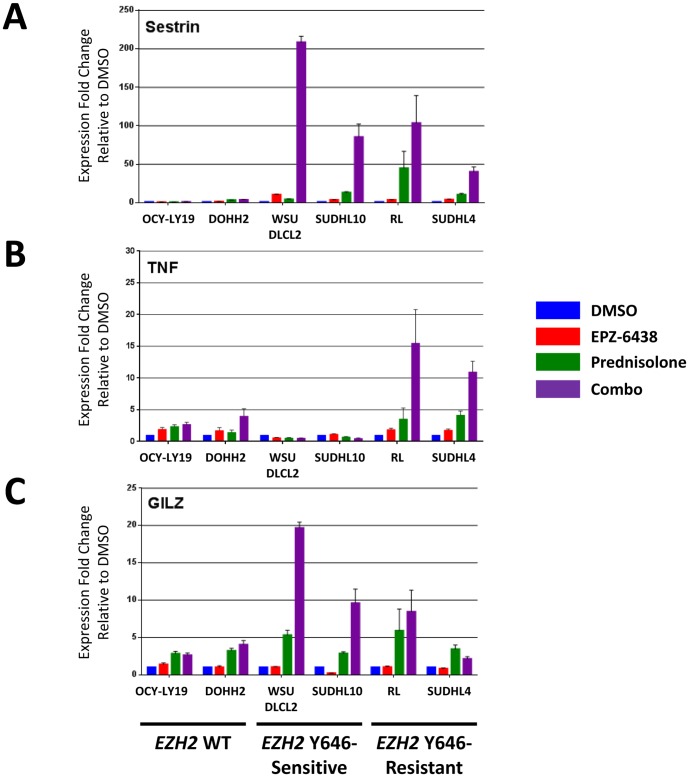
Glucocorticoid target genes are up-regulated by prednisolone/EPZ-6438 combination in EZH2 mutant cell lines.Expression levels of Sestrin 1 (SESN1, A), TNF (B) and GILZ (C), normalized to DMSO controls, for each cell line treated with the indicated single agents or their combination (2 biological replicates, see materials and methods section 5 for details). Fold change values were quantified using the ΔΔCt method, and ACTB, B2M and GAPDH as reference genes. Error bars represent SEM values. Statistical analysis of the data is presented in table 2. WT: wild-type.